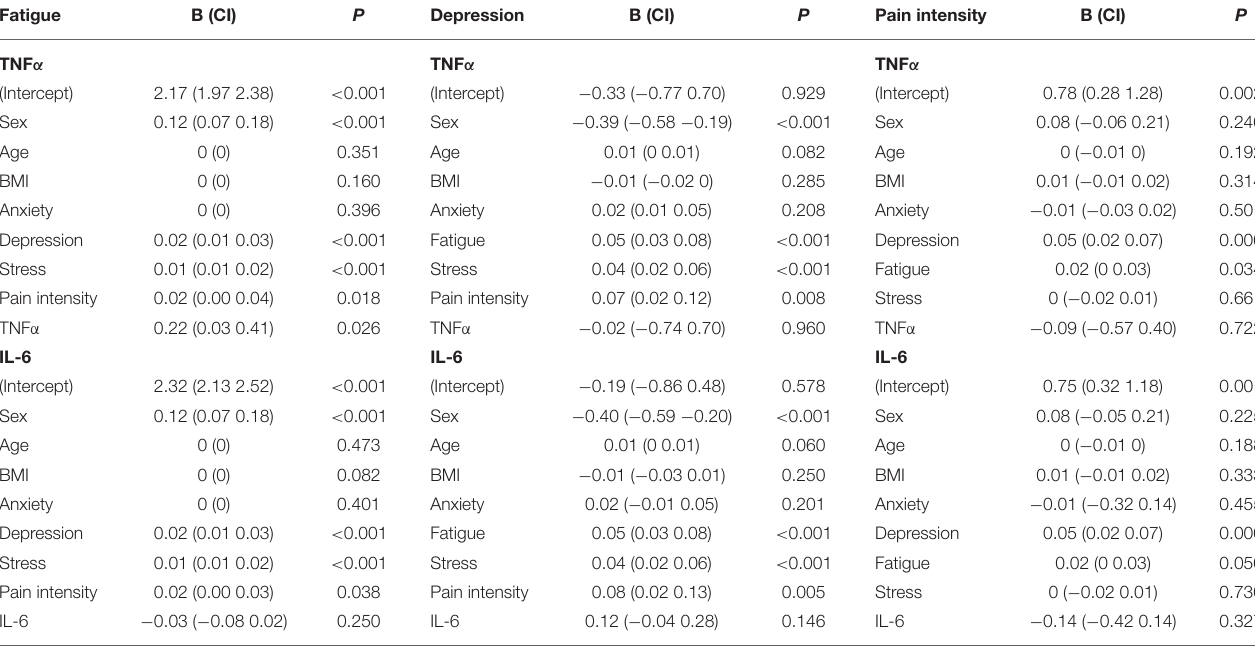
TABLE 3 | Relationship between TNF α and IL-6, respectively, to fatigue, depression and pain intensity.